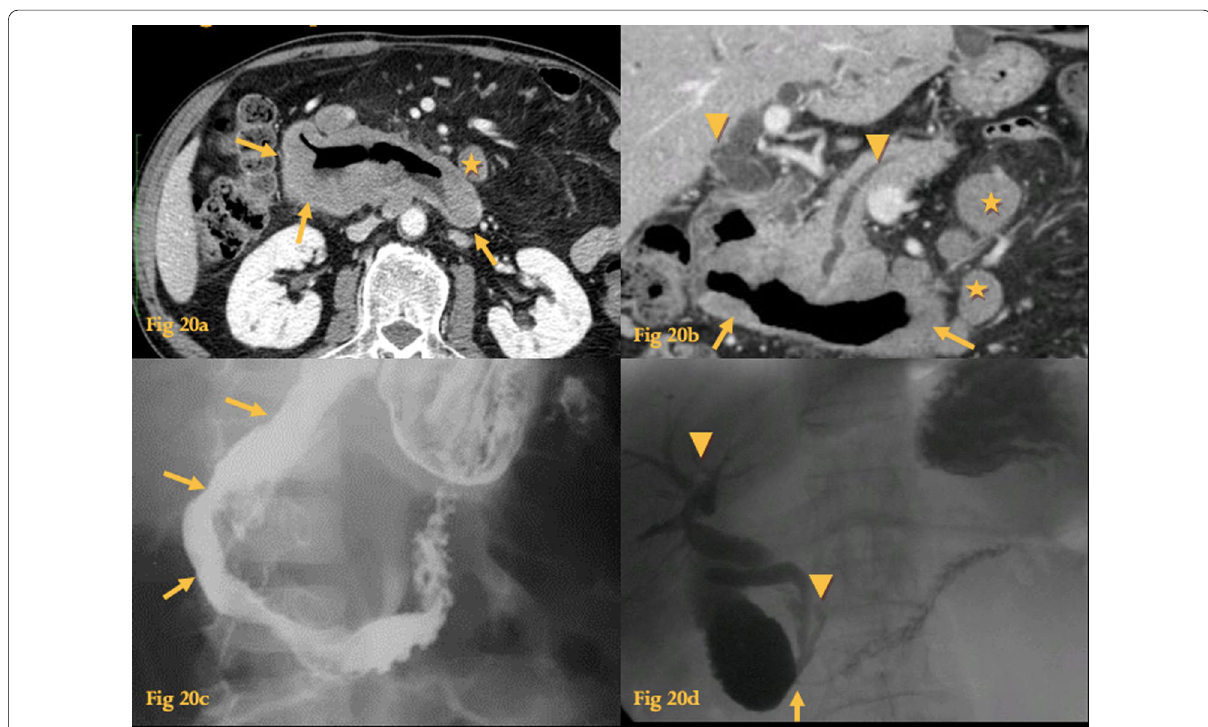
Fig. 20 Lymphoma. Contrast‑enhanced CT ( a , b ) shows homogeneous and asymmetric thickening of the duodenal wall with mild dilatation of the lumen (arrows); there is biliary and Wirsung duct dilatation (arrowheads); paraduodenal adenopathy is also evident (asterisks). UGIS of the same patient ( c ) shows loss of the normal mucosal pattern of folds at the descending duodenum (arrows). UGIS some months after the first UGIS, while on chemotherapy ( d ) shows abrupt luminal narrowing at the horizontal duodenum (arrow), with dilatation of the proximal duodenal segments. Because of increased pressure at the stenosis, there was contrast reflux to the biliary ducts and Wirsung duct